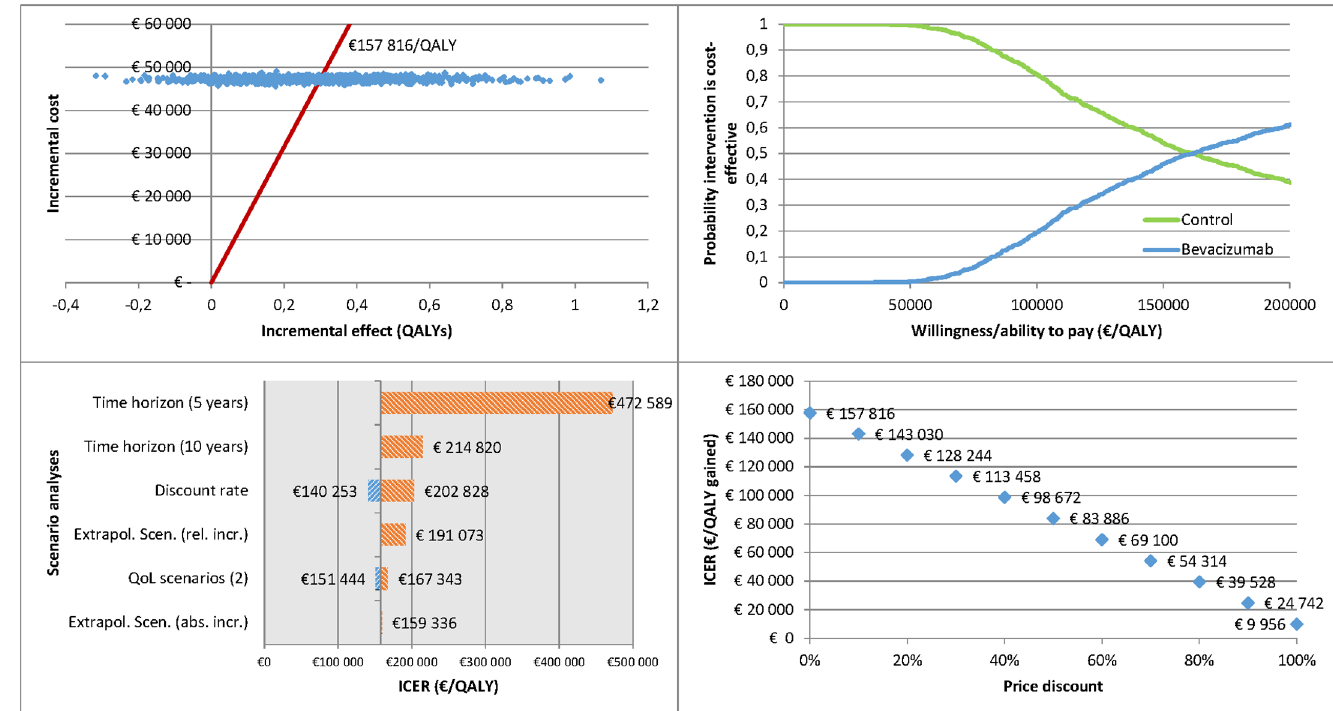
Fig 1. Results of the economic evaluation for the GOG-0218